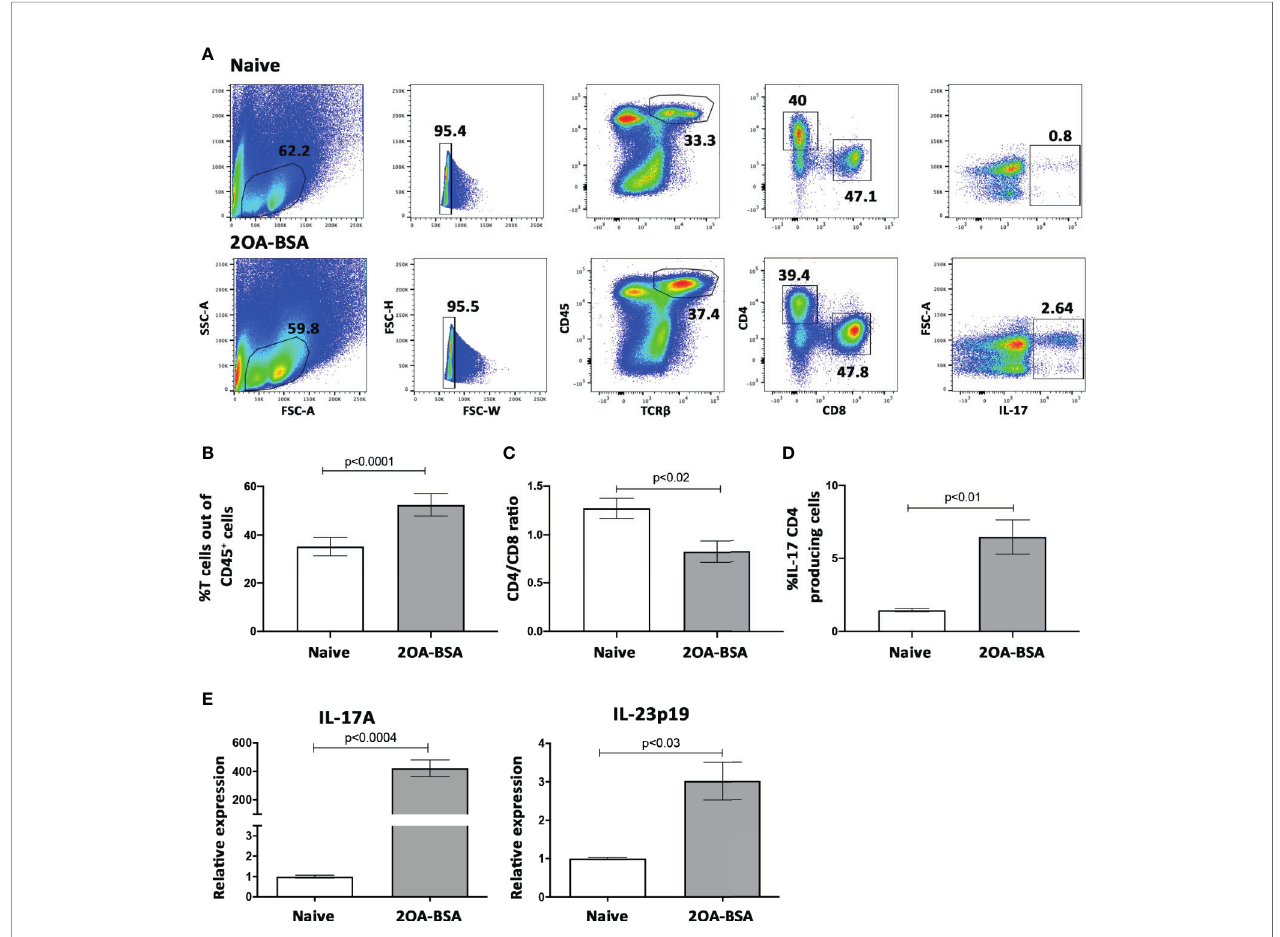
FIGURE 2 | IL-23-T H -17 pathway is activated in the 2OA-BSA autoimmune cholangitis model. 2OA-BSA immunized mice and match-aged naïve mice were evaluated for: (A) Flow cytometry analyses of puri fi ed non-parenchymal liver cells, with a focus on intra hepatic T cells, from naïve mice (upper panel) and 2OA-BSA immunized mice (lower panel). (B) Graphical summary of the percentages of T cells out of CD45-positive cells. (C) Graphical summery of the CD4/CD8 T cell ratio. (D) . Graphical summery of the percentages of IL-17 CD4-positive producing cells. (E) Relative expression of hepatic IL-17A and IL-23p19 assessed by qPCR. Results presented as mean ± SEM (n ≥ 5) for each group. Results are representative of two independent experiments. p values < 0.05 were considered as signi fi cant (unpaired Student ’ s